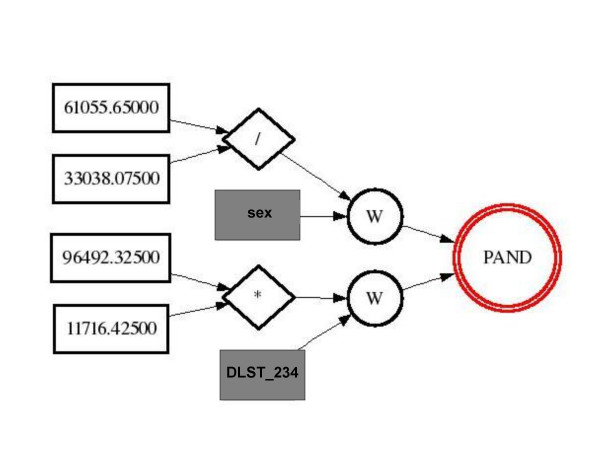
GPNN model for Parkinson's Disease data. A GPNN model that was evolved by GPNN on the PD data. The real numbers are used to create weights and fill in for the W nodes. The individual values of sex and DLST_234 fill into those nodes. The activation function is a Boolean function AND, thus it will take (61055.5/33038.075)*sex AND (96492.325*11716.425)*DLST_234.